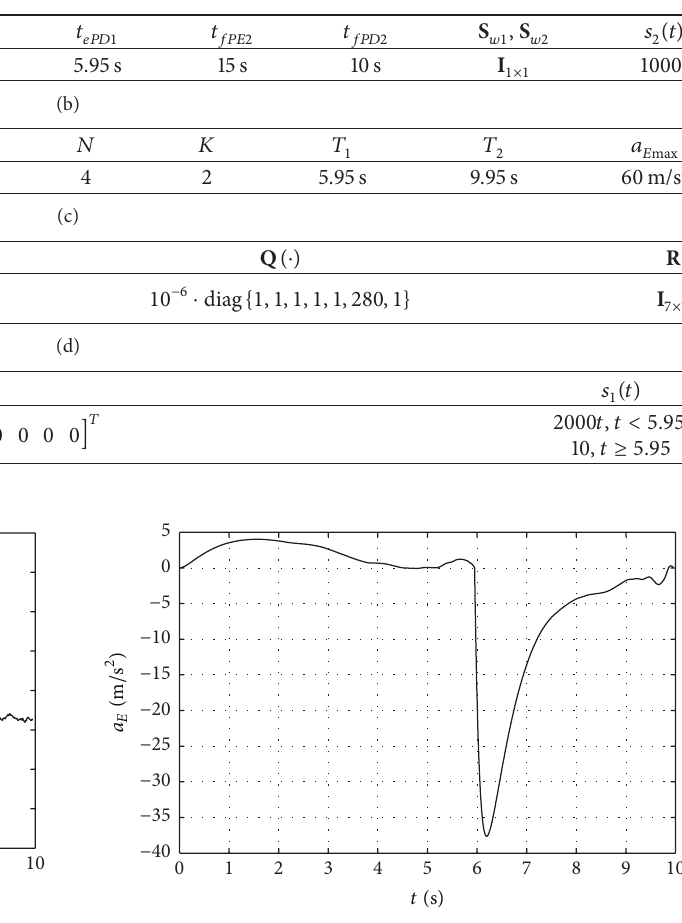
Figure 17: The LOS angle velocities between the two Defenders and the two Pursuers.